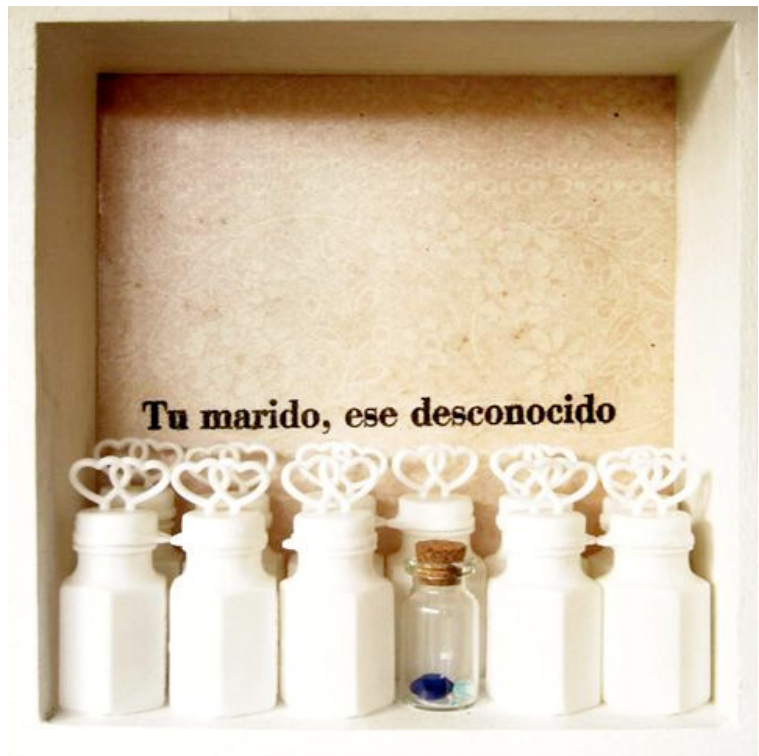
Figure 6. Clara Gaviria, shadow box, 2011. Image provided by the artist.